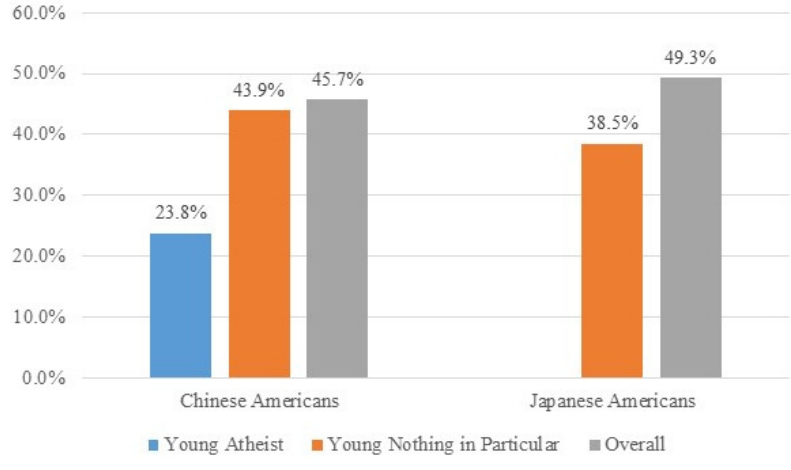
Figure 12. Top goal: having a good marriage.